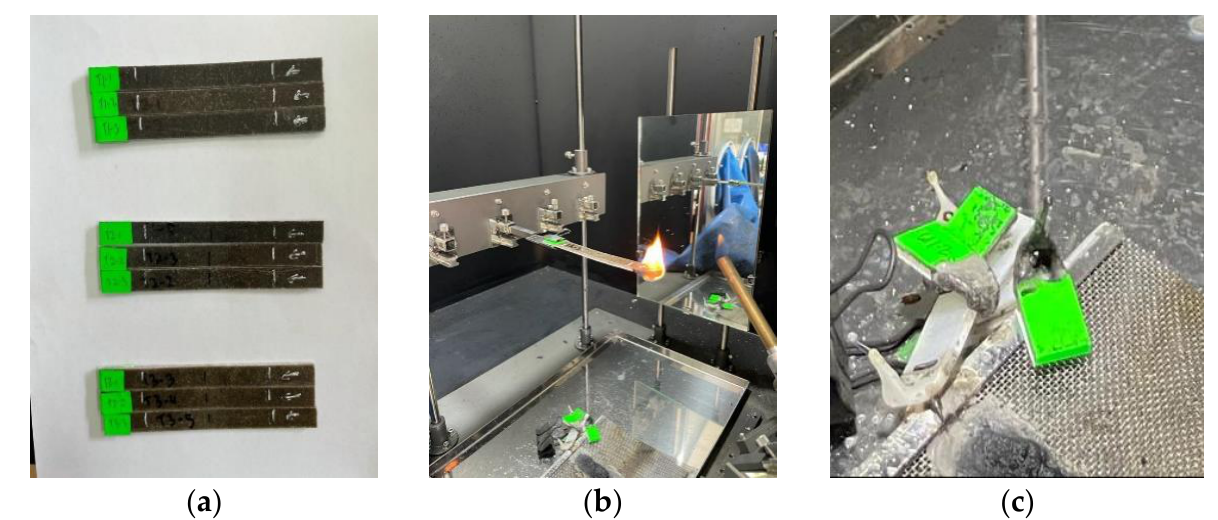
Figure 1. ( a ) Composite hybrid (SP/K/PP); ( b ) Composite hybrid (SP/K/PP) performance in flammability test; ( c ) Sample debris after test 3.